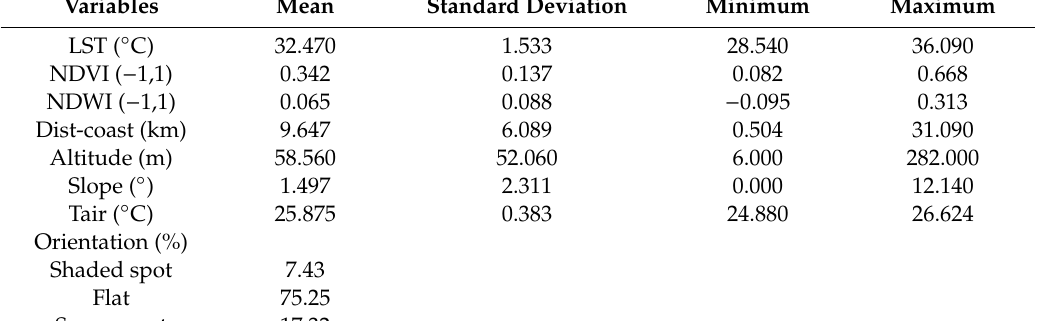
Table A1. Descriptive statistics on dependent and independent variables.